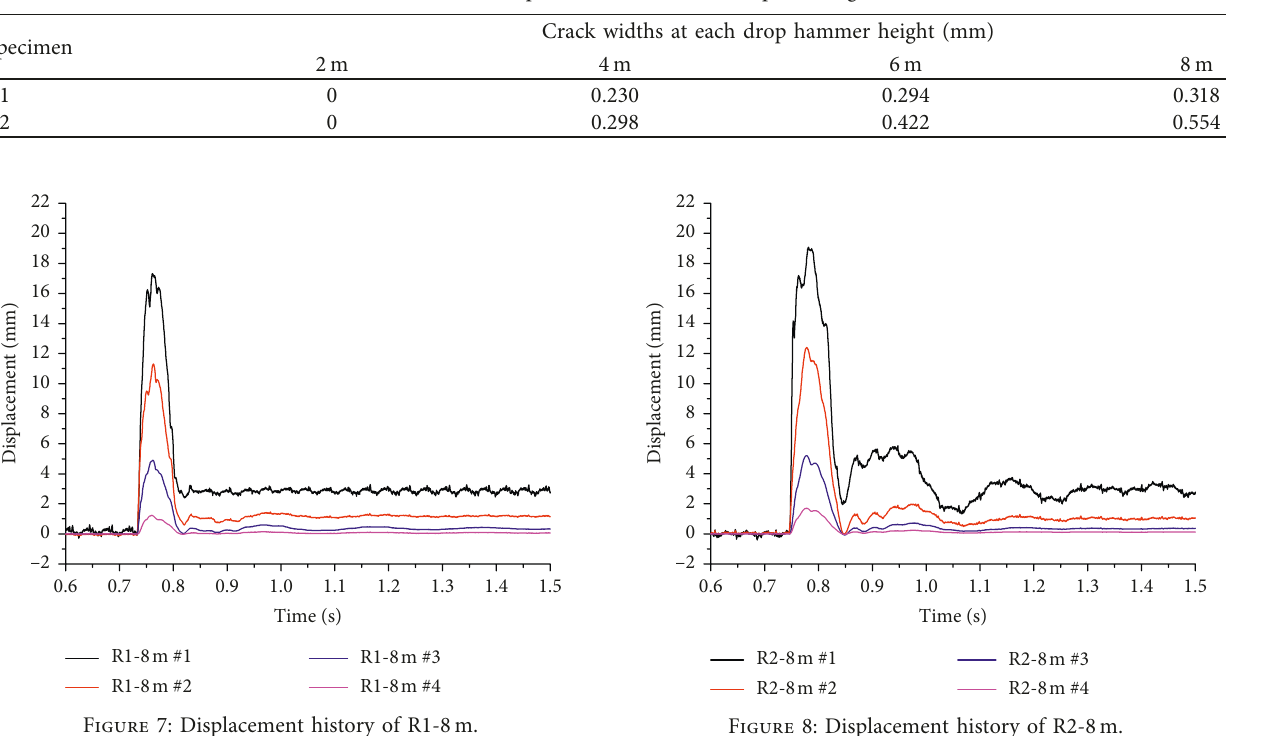
Figure 6: Damage factor change curve after each impact. Table 4: Crack development under different impact energies.